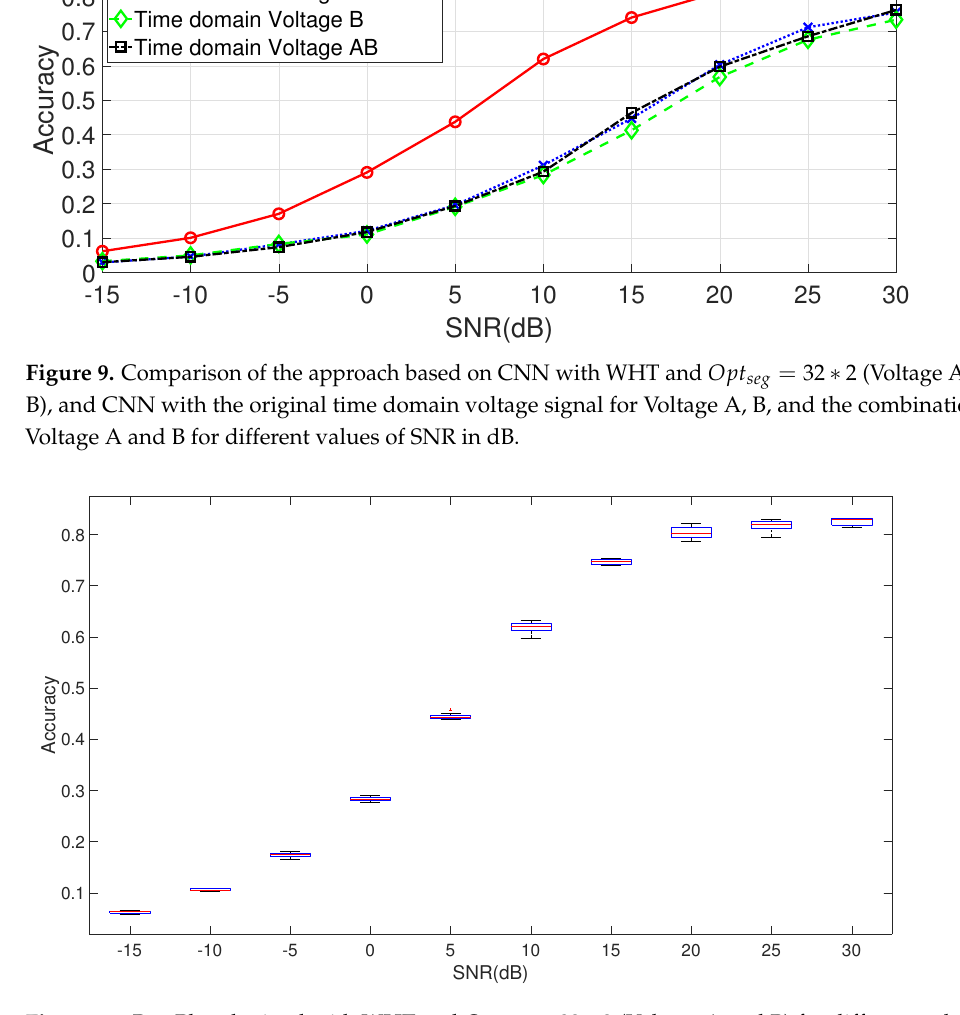
Figure 10. Box Plot obtained with WHT and Opt seg = 32 ∗ 2 (Voltage A and B) for different values of SNR in